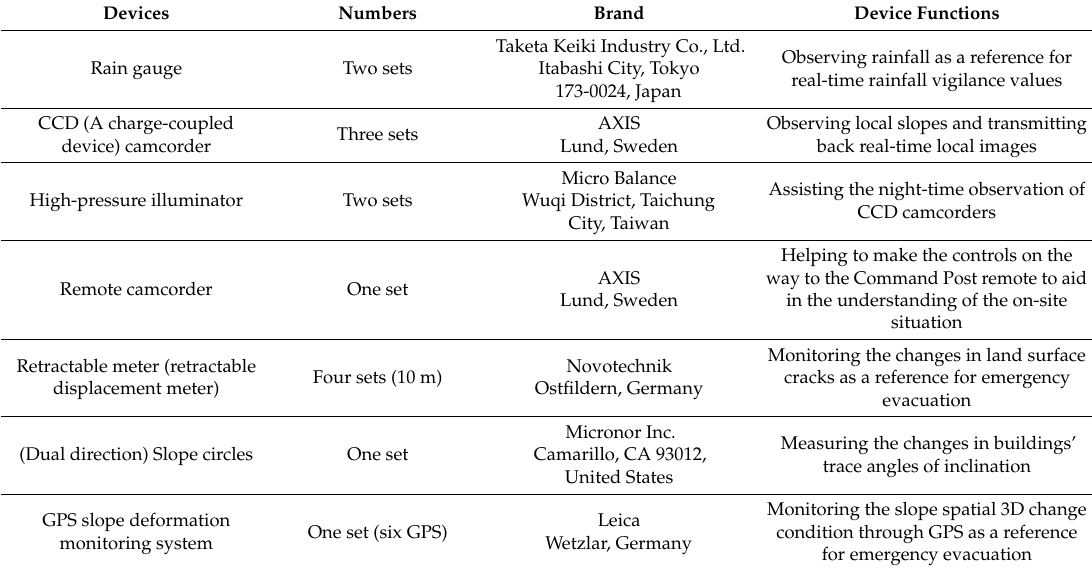
Table 1. Quantities and descriptions of the observation facilities